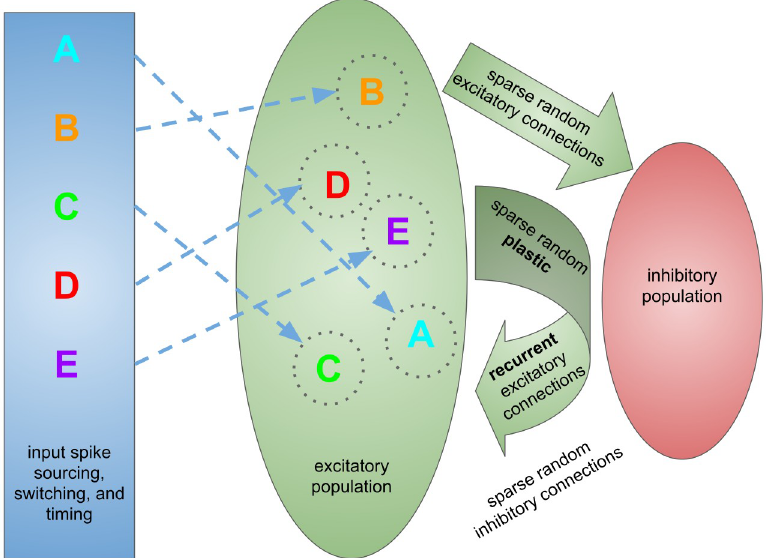
Fig 1. Network architecture. A symbolic diagram of the network architecture for the virtual experiment. The input layer, which provides learning signals, recall cues, and distractors in the form of spikes, and its (feedforward) connections to the main network are shown in blue. The excitatory portion of the network and its associated excitatory connections (both recurrent and feedforward) are shown in green. The inhibitory portion of the network and its associated inhibitory feedback connections are shown in